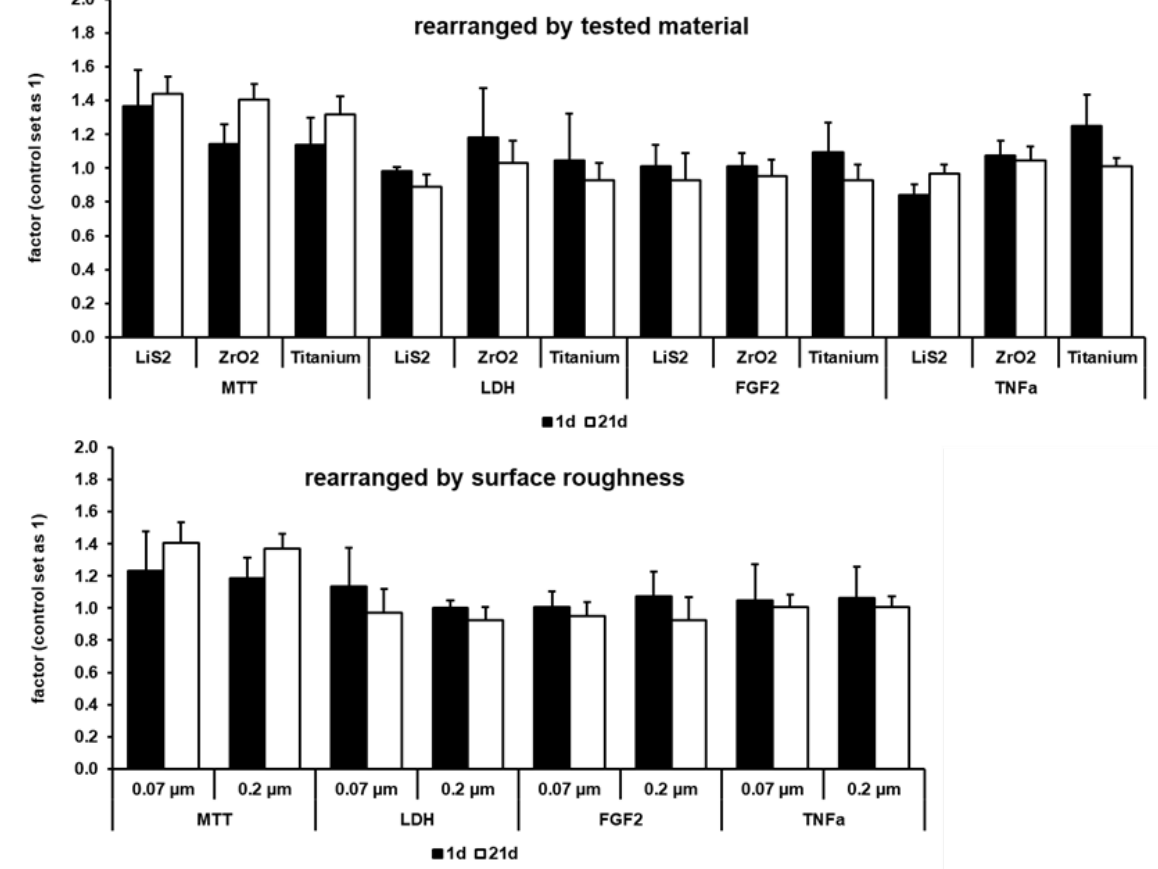
Figure 2. Cell viability of HGF-1 cells growing on different specimen disks at day 1 and day 21, rearranged by tested material ( p = 0.0002) and surface roughness ( p = 0.000014). Factors correlated to control (set as 1) are shown. Proliferation rate was described by an MTT assay ( p = 0.017 for material and p = 0.009 for roughness); cytotoxicity was described by the release of LDH in culturing media ( p = 0.009 for material and for roughness); grade of differentiation potential was described by the expression of FGF2 (significant for titanium group, with p = 0.036, and for 0.2 µm roughness group, with p = 0.009); possible inflammation reaction was described by the expression of TNF α (significant, with p = 0.009, in roughness and significant, with p = 0.015, in LiS 2 and titanium groups).